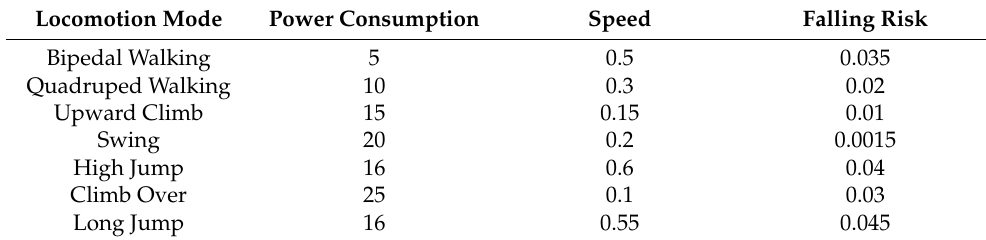
Table 1. The assumed MLR data.